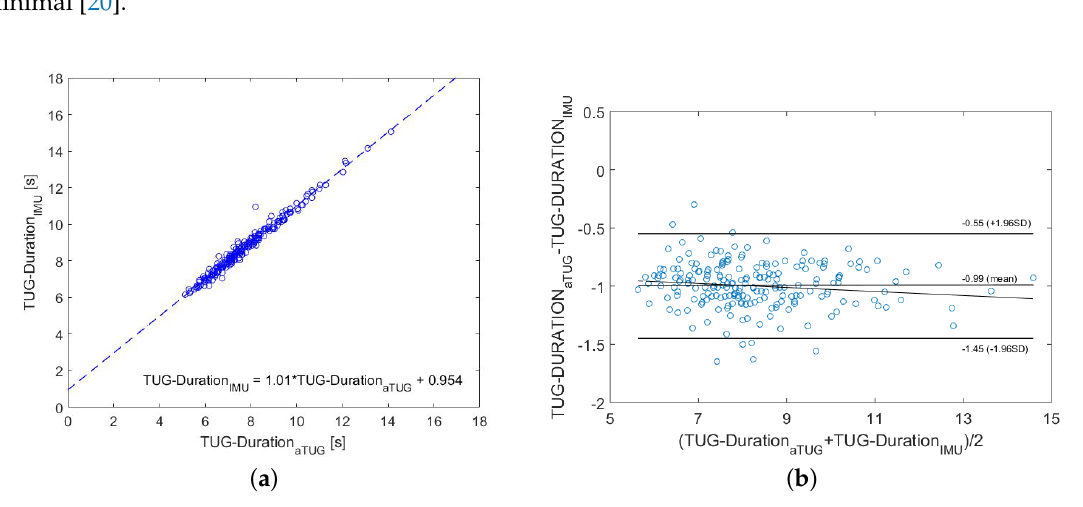
Figure 9. Comparison between aTUG and IMU measurements. The dashed line represents the linear regression line and corresponds to the stated equation in ( a ). The Bland–Altman plot and its characteristic values are shown in ( b ). ( a ) Correlation analysis; ( b ) Bland–Altman